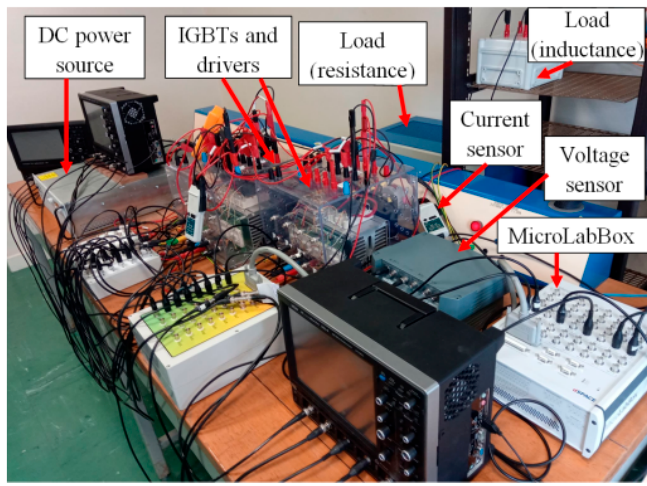
Figure 9. Experimental setup.